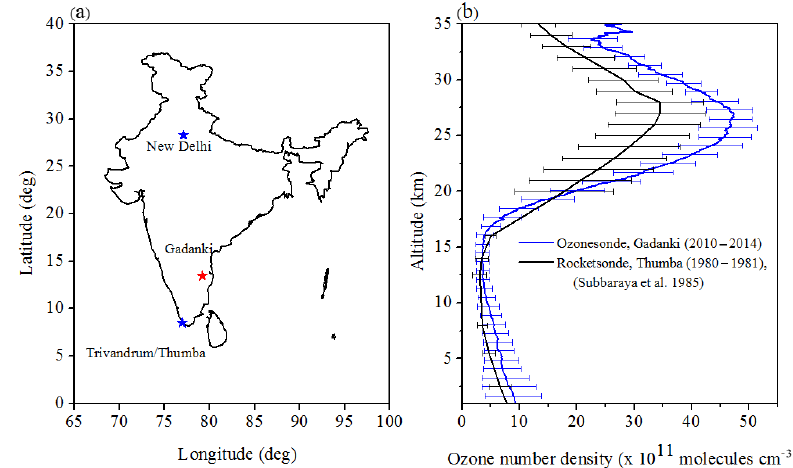
Figure 1. (a) Map showing the Indian subcontinent with Trivandrum, Gadanki, and New Delhi locations. (b) Comparison of rocketsonde ozone profiles (black) observed over Trivandrum during 1980–1981 with ozonesonde profiles (blue) observed over Gadanki during 2010–